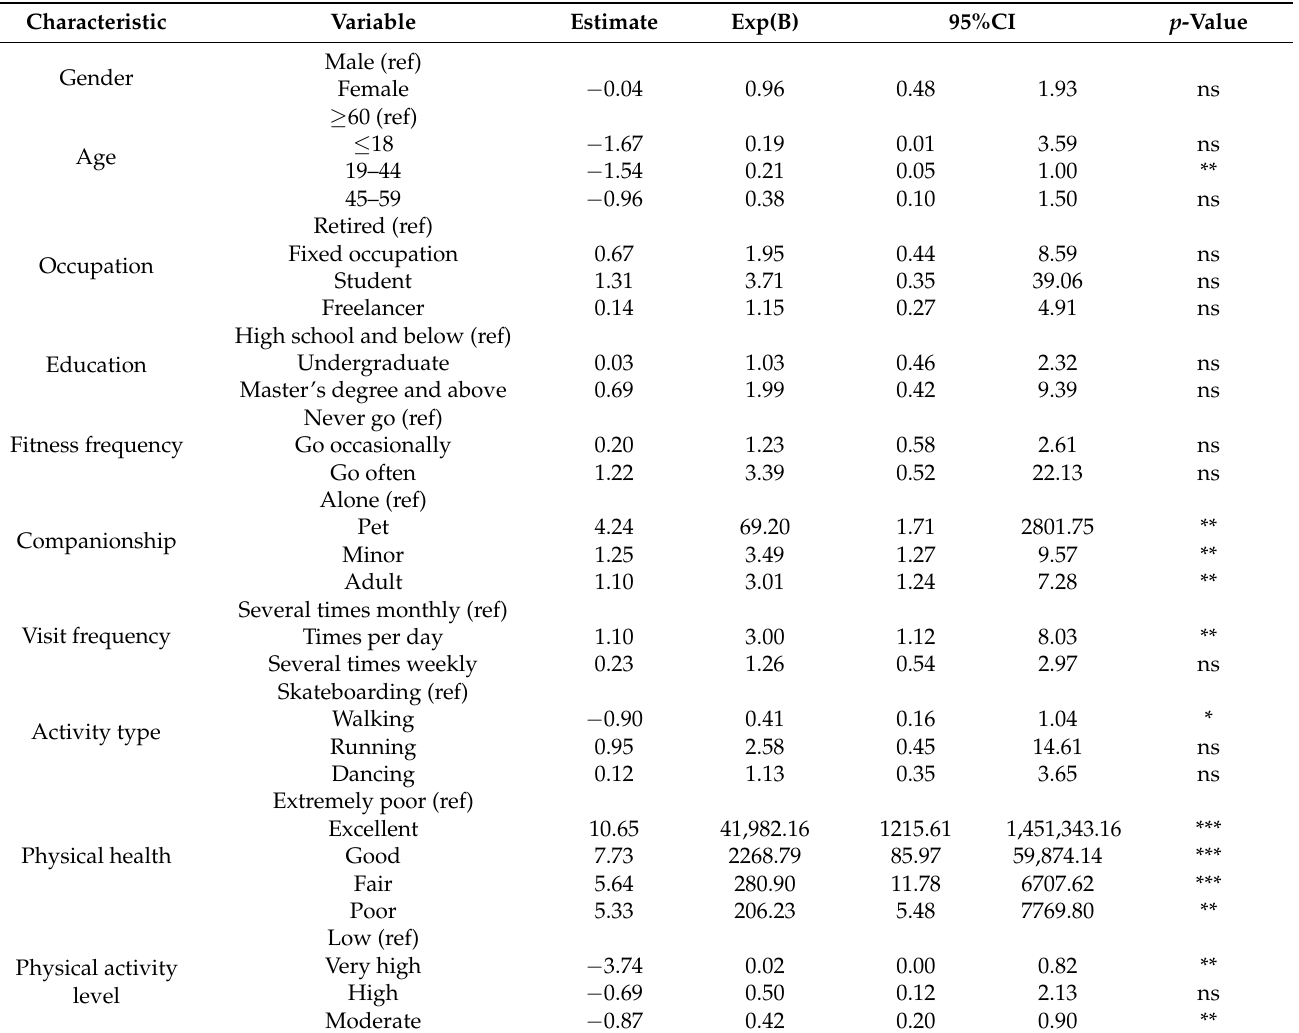
Table 6. Ordered logistic regression analysis on the influencing factors of mental